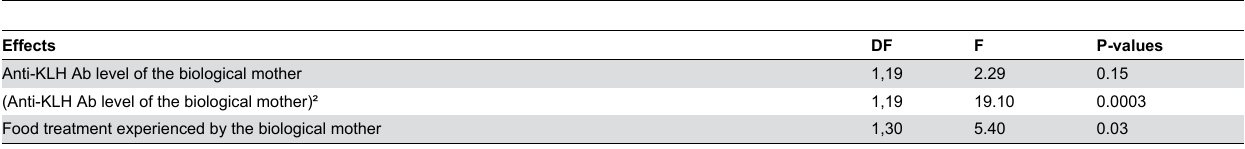
Table 1. Output of the best-fit generalized mixed model that explains anti-KLH Ab levels in 3-day-old chicks.